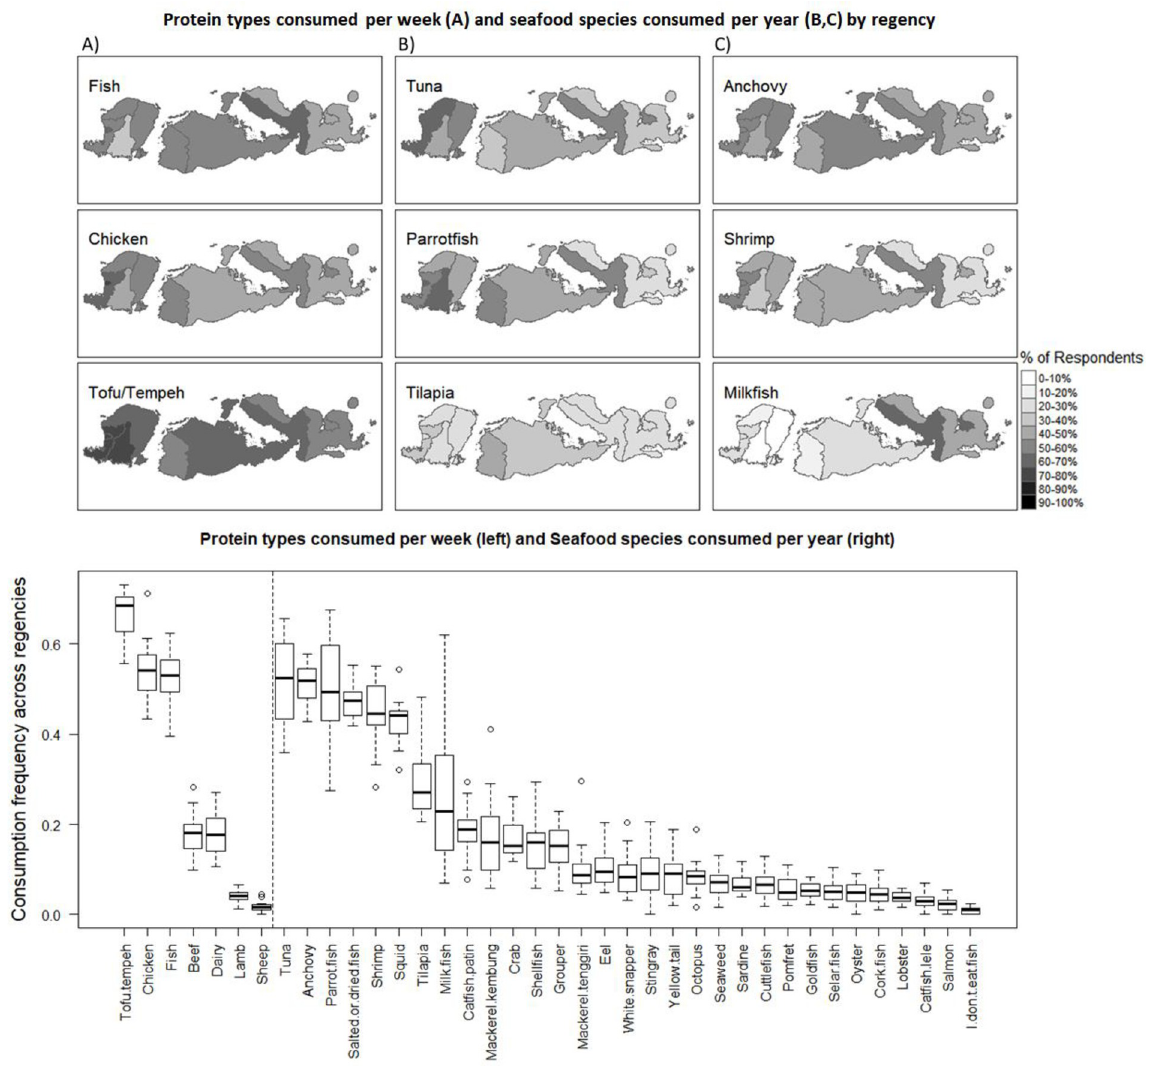
Fig 3. Spatial distribution of the average frequency per regency of protein types eaten per week (top A) and the average frequency per regency of 6 of the most frequently consumed seafood species per year with the highest variability across regencies (Top B,C). On the bottom, the quartile frequency distribution across regencies of each protein type per week (bottom left) and each seafood species per year (bottom right).